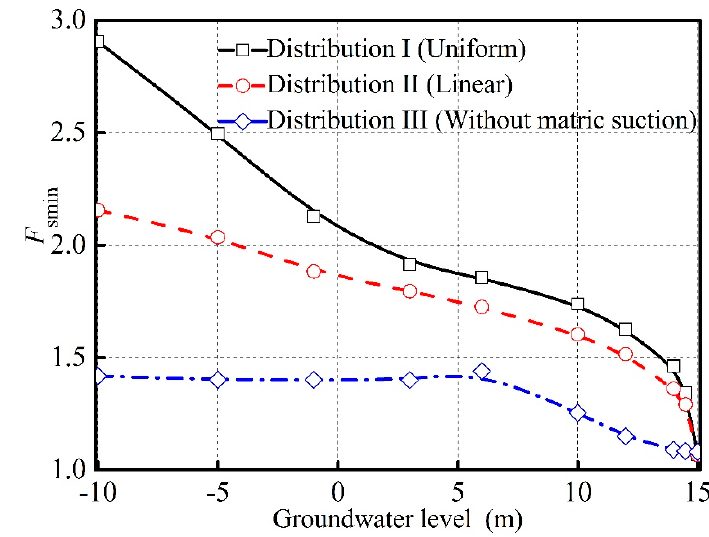
Figure 11. Effect of distribution pattern of matric suction on safety factor under rainfall infiltration. Figure 11. E ff ect of distribution pattern of matric suction on safety factor under rainfall